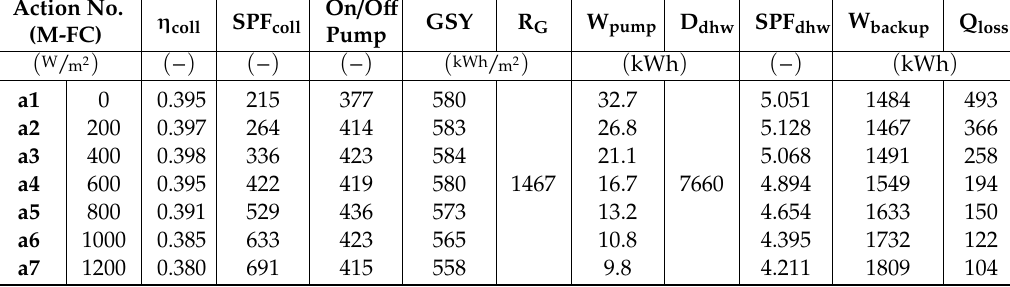
Table 4. Comparison of performance using di ff erent controllers of the (M)-FC family; yearly data. Action No.